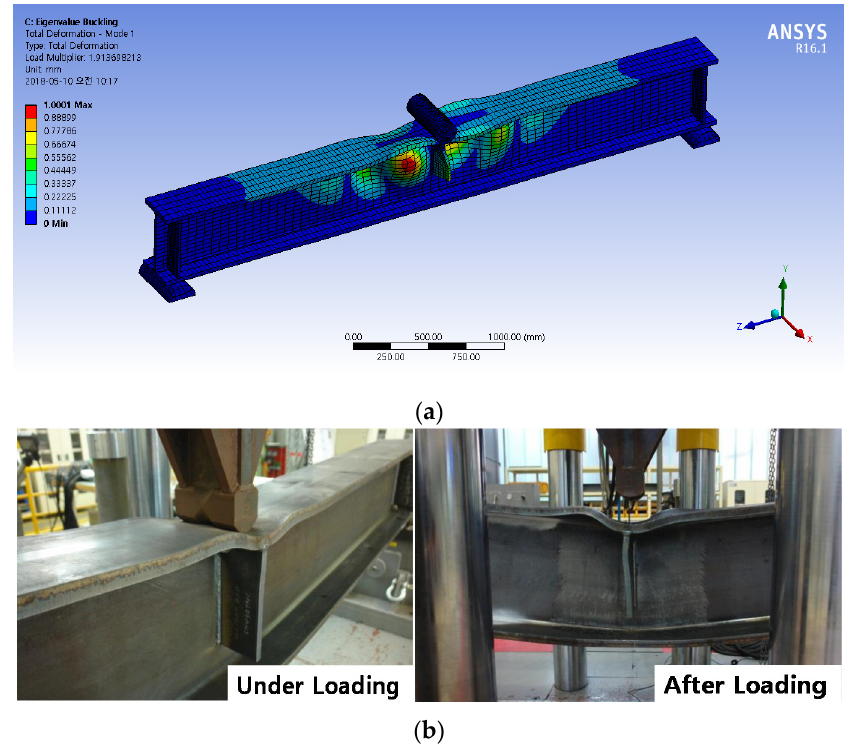
Figure 13. B uckling mode. ( a ) Analysis; ( b ) experimental specimen